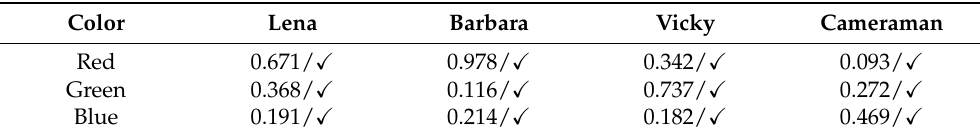
Table 11. The randomness measurement using the Discrete Fourier Transform ( (cid:88) Accept, x Reject), with α = 0.01.